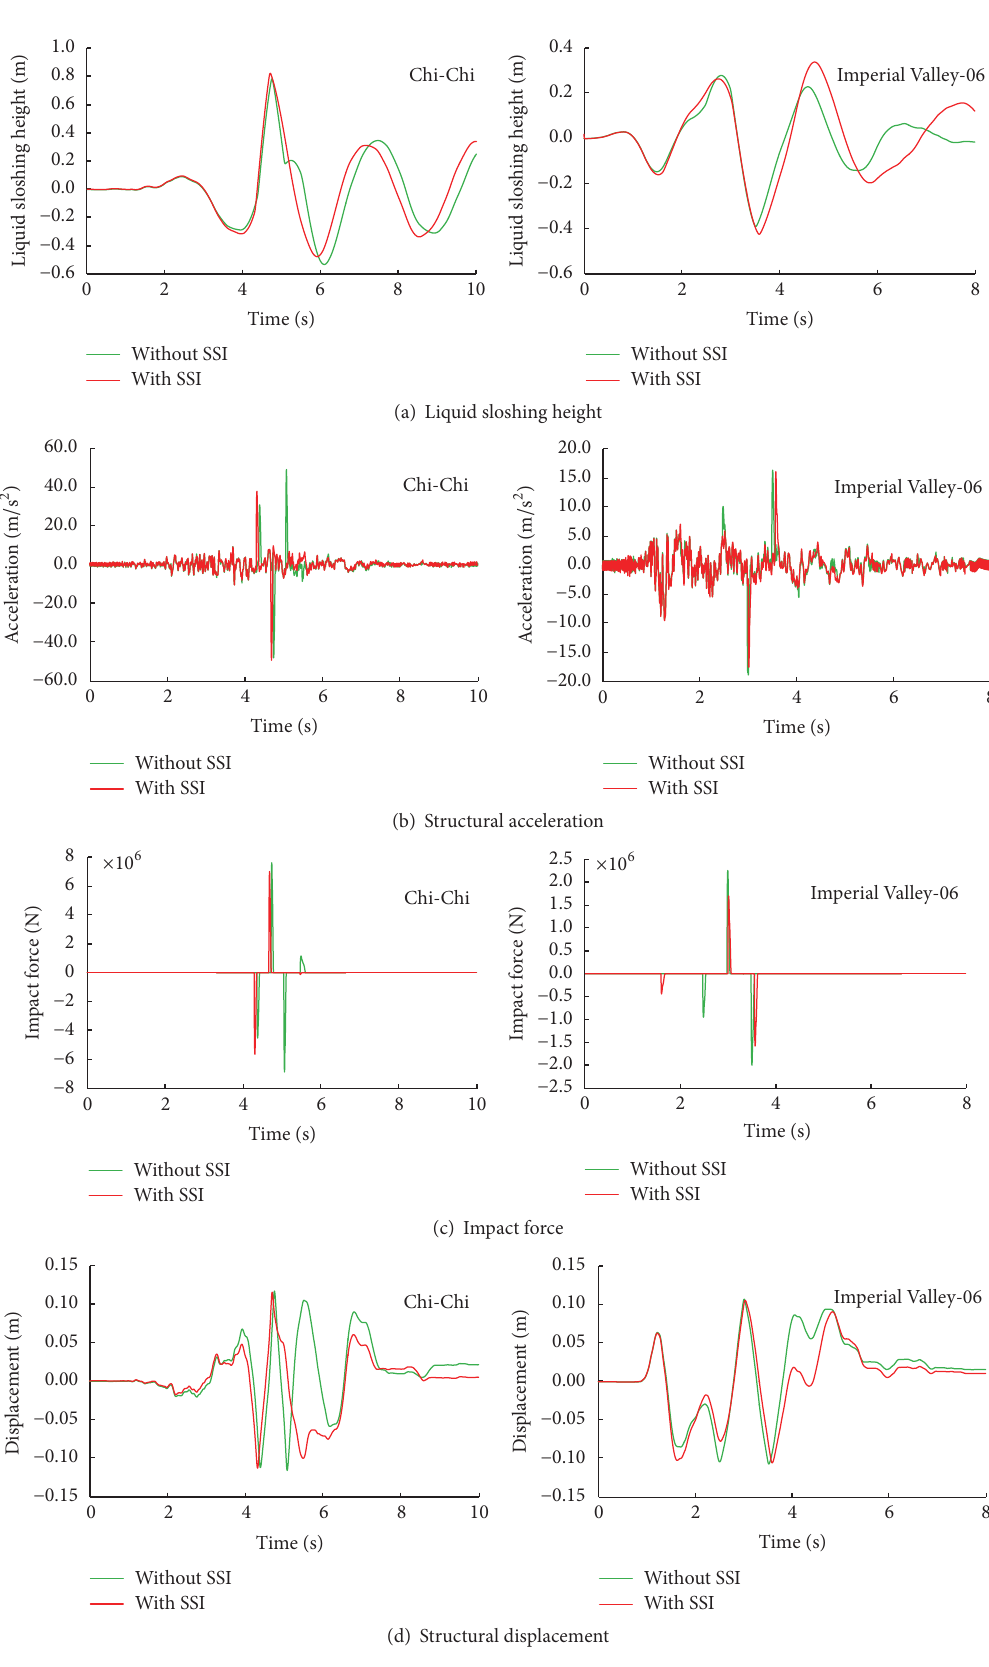
Figure 5: Effect of SSI on structural dynamic responses considering